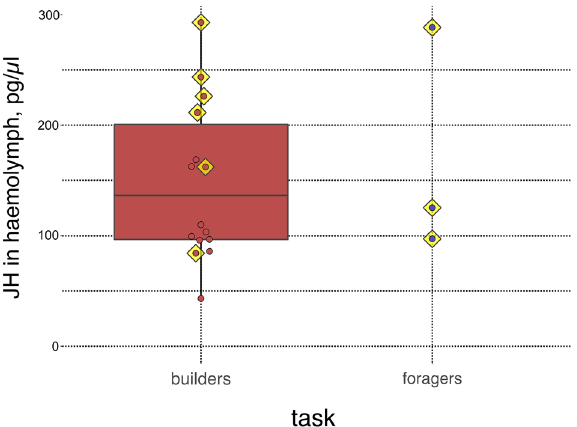
Figure 2. Boxplot of JH titres in builders compared to foragers. Builders and foragers did not differ significantly in their haemolymph JH titres (Mann Whitney U test: N = 17, U = 18.0, p = 0.705) (Supplementary Table S5). Box plot elements are defined as follows: Centre line: Median. Box range: 25 and 75 percent quartiles. Dots : Individual data points. Yellow squares under dots : Presence of uric acid. For the three data points of the foragers , no box was drawn as quartiles are not